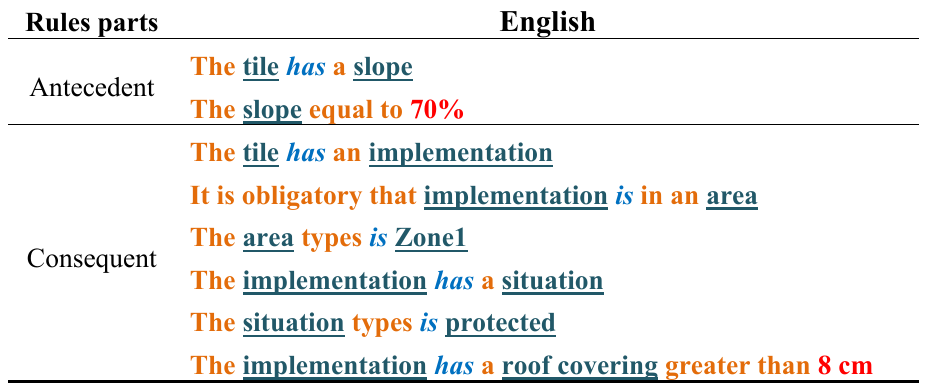
Table 1. Decomposing SBVR rules into Antecedent and Consequent.